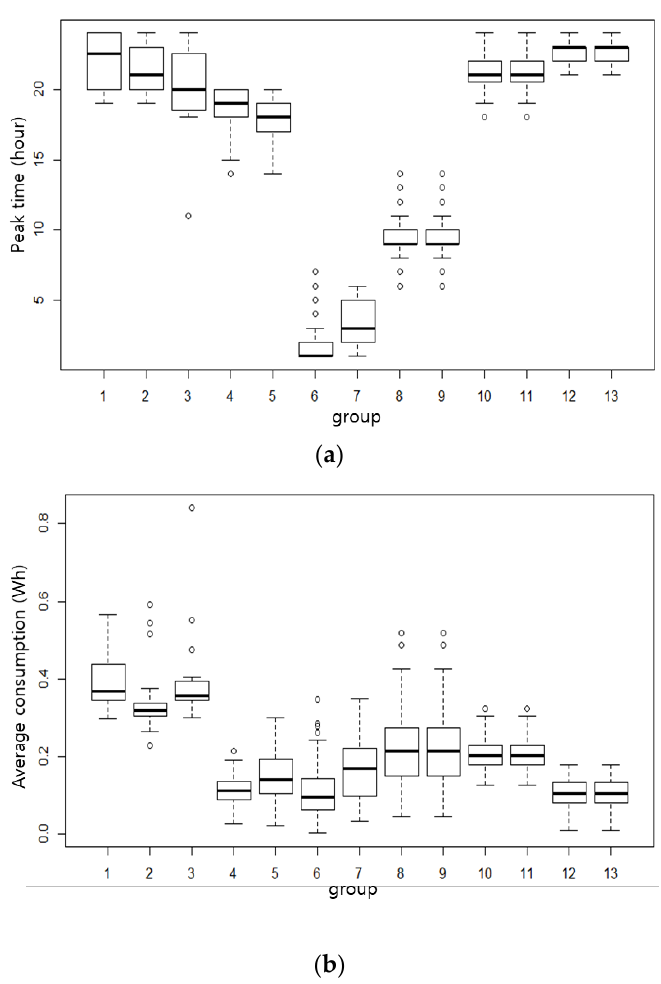
Figure 8. Boxplot of the proposed clustering method: ( a ) peak time, and ( b ) average consumption.